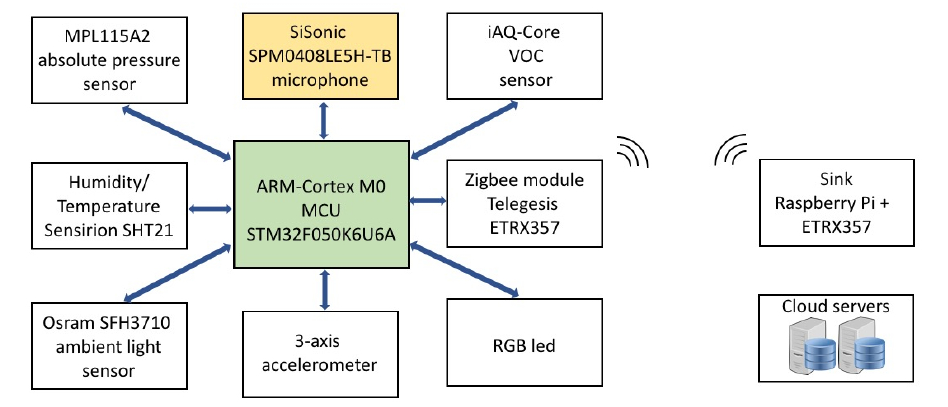
Figure 2. Architecture of the wireless sensor node.